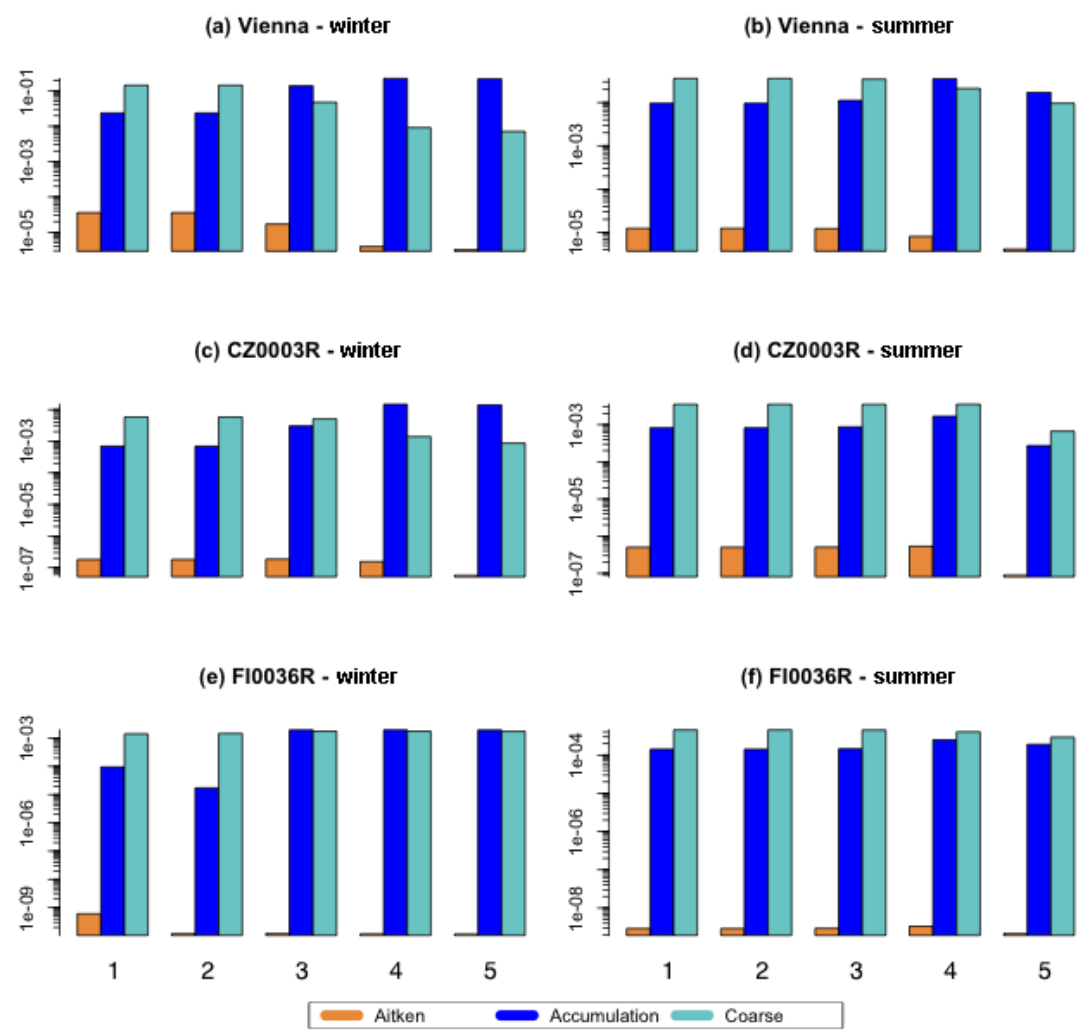
Figure 6. Distribution of BaP mass [log c BaP (ngm − 3 ) ] in aerosols of three different modes in three different cells [urban (Vienna), suburban (CZ0003R), and remote (FI0036R)] for each scenario as calculated during a winter (20 January) and a summer (20 July)